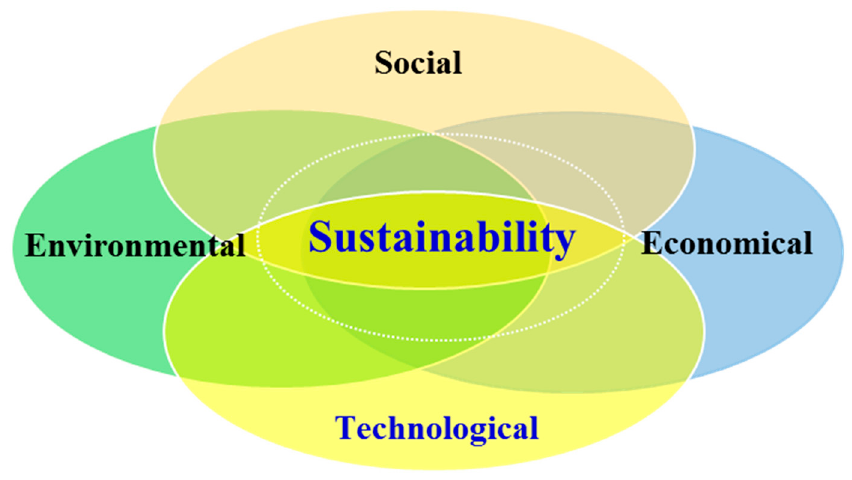
Figure 1. The main pillars of sustainable construction (created by the authors).